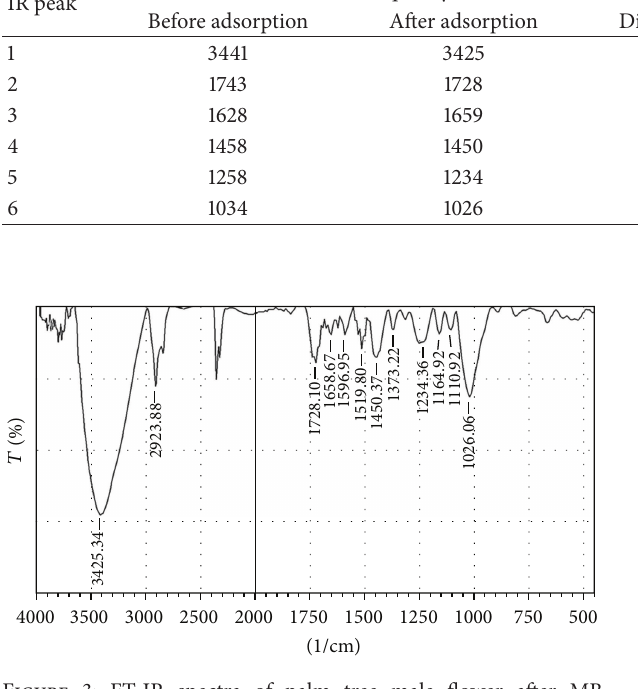
Figure 3: FT-IR spectra of palm tree male flower after MB adsorption.